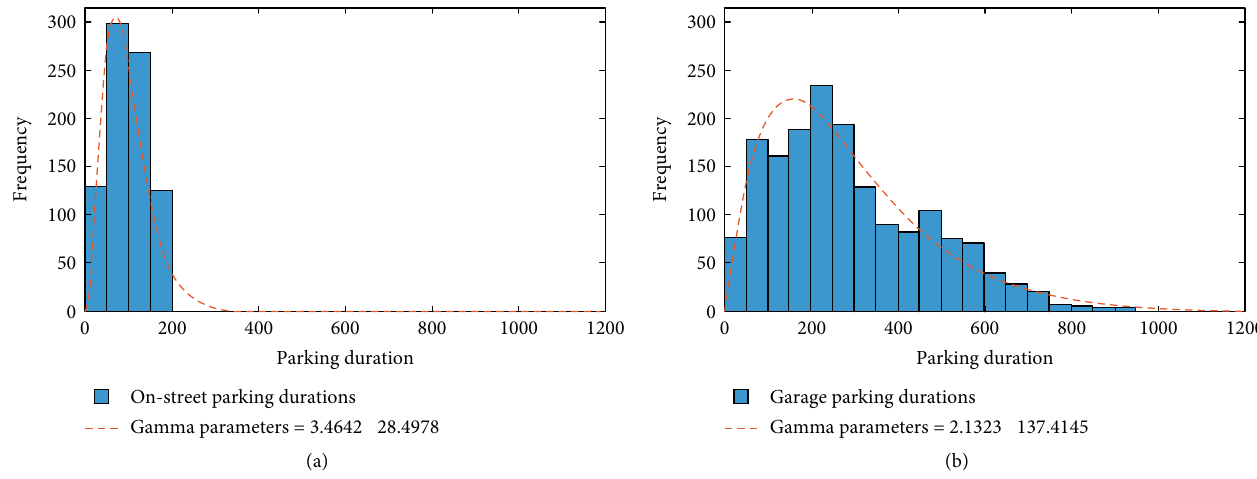
Figure 5: Parking durations for on-street and garage parking. (a) Histogram of the on-street parking durations. (b) Histogram of the garage parking